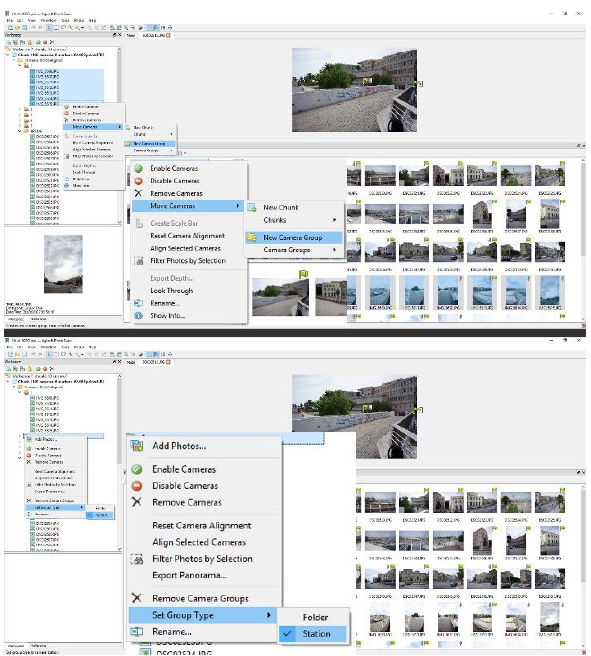
Figure 12: Uploading Fish-eye photos in Photoscan.